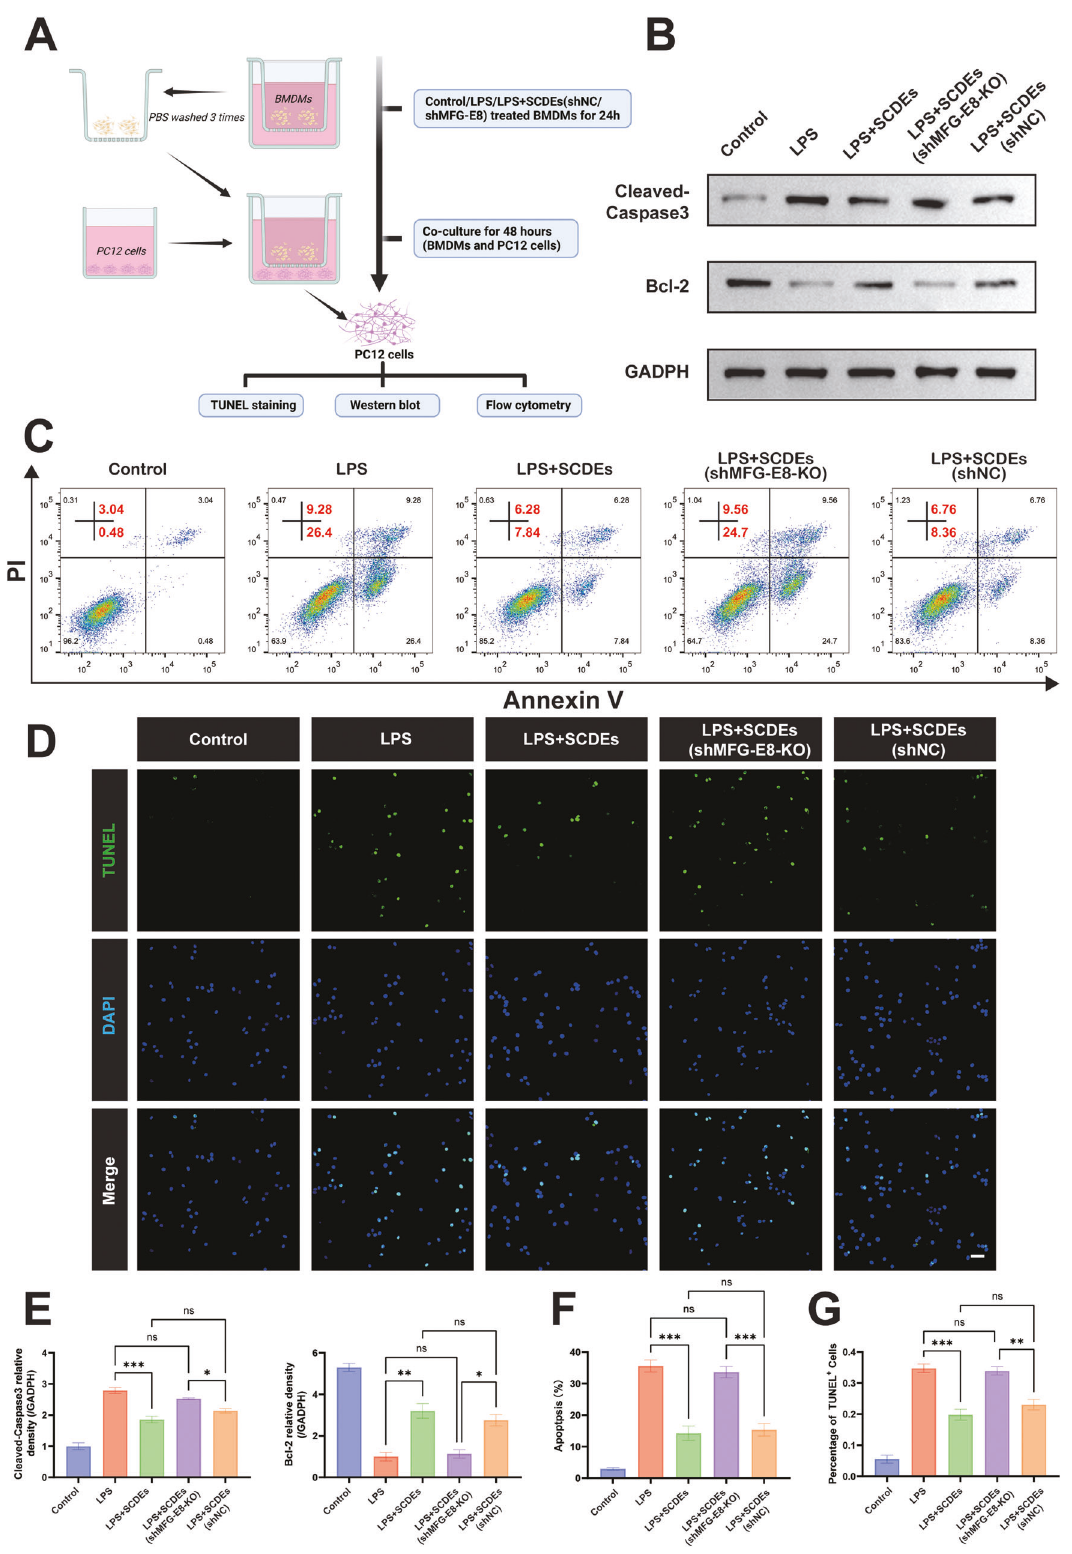
Fig. 8 Improved in fl ammatory microenvironment inhibited neuronal apoptosis. A Schematic representation of co-culture of PC12 cells and BMDMs. B , E Representative western blots of Cleaved Caspase-3 and Bcl-2 in PC12 cells. Quantitative analysis of the Cleaved Caspase-3/ GAPDH ratio and Bcl-2/GAPDH ratio in PC12 cells ( n = 3). C , F Flow cytometry assay detected apoptosis of PC12 cells in each group, showing that SCDEs inhibited LPS-induced apoptosis and that the knockout of MFG-E8 reversed the positive effect ( n = 3). D , G The TUNEL staining of PC12 cells showed that SCDEs reduced TUNEL + cells while MFG-E8 knockout increased TUNEL + cells ( n = 3). Scale bar: 50 μ m. Data were presented as mean ± SEM. Results were analyzed by One-way ANOVA. Signi fi cance: ns-not signi fi cant, * P < 0.05, ** P < 0.01, *** P < 0.001.